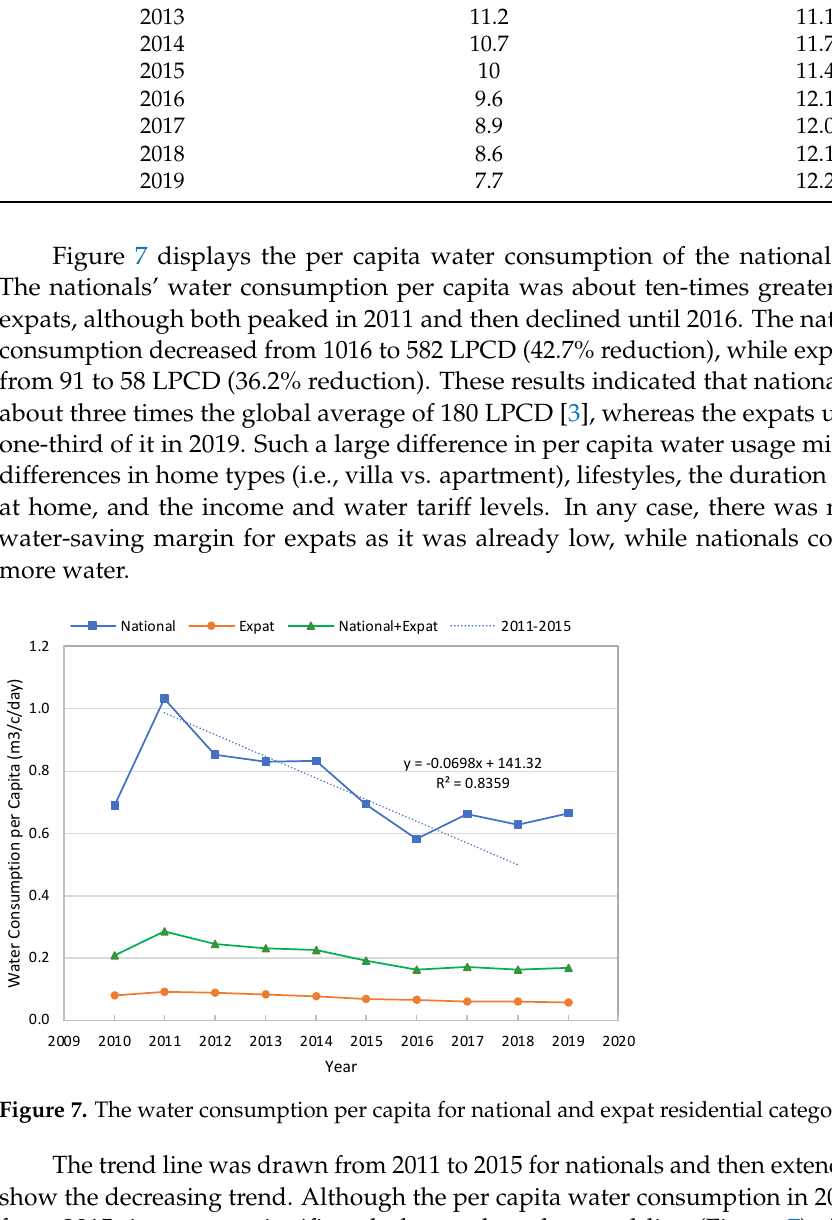
Table 2. Persons per connection for national and expat populations.